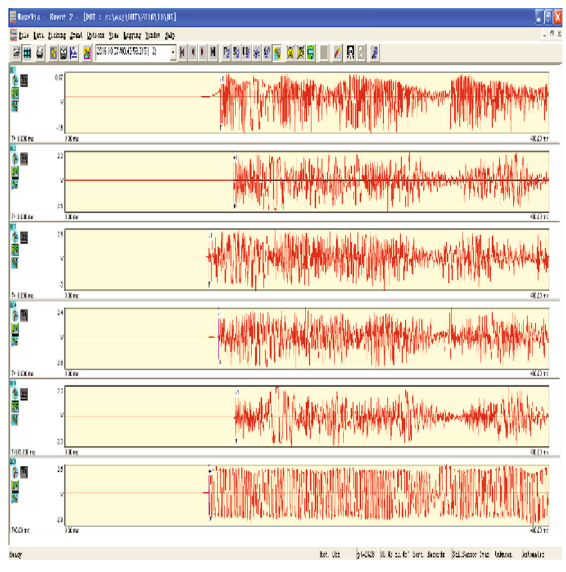
Figure 29: Blasting event waveform.